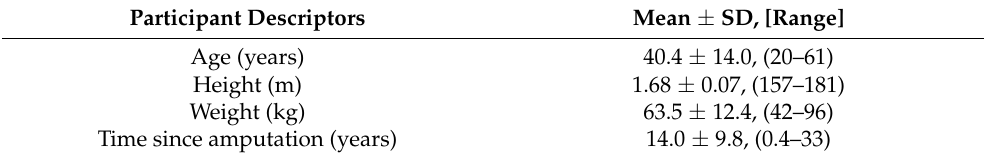
Table 1. Participant characteristics.